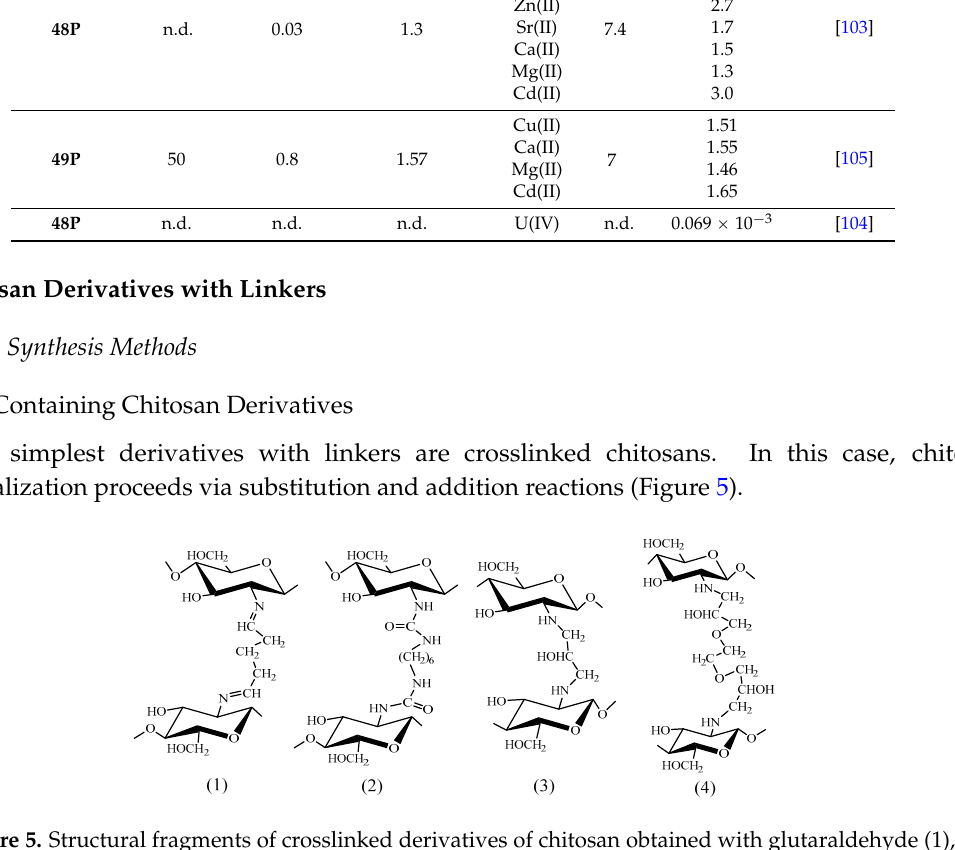
Table 5. Structure and sorption properties of P-containing chitosan derivatives.